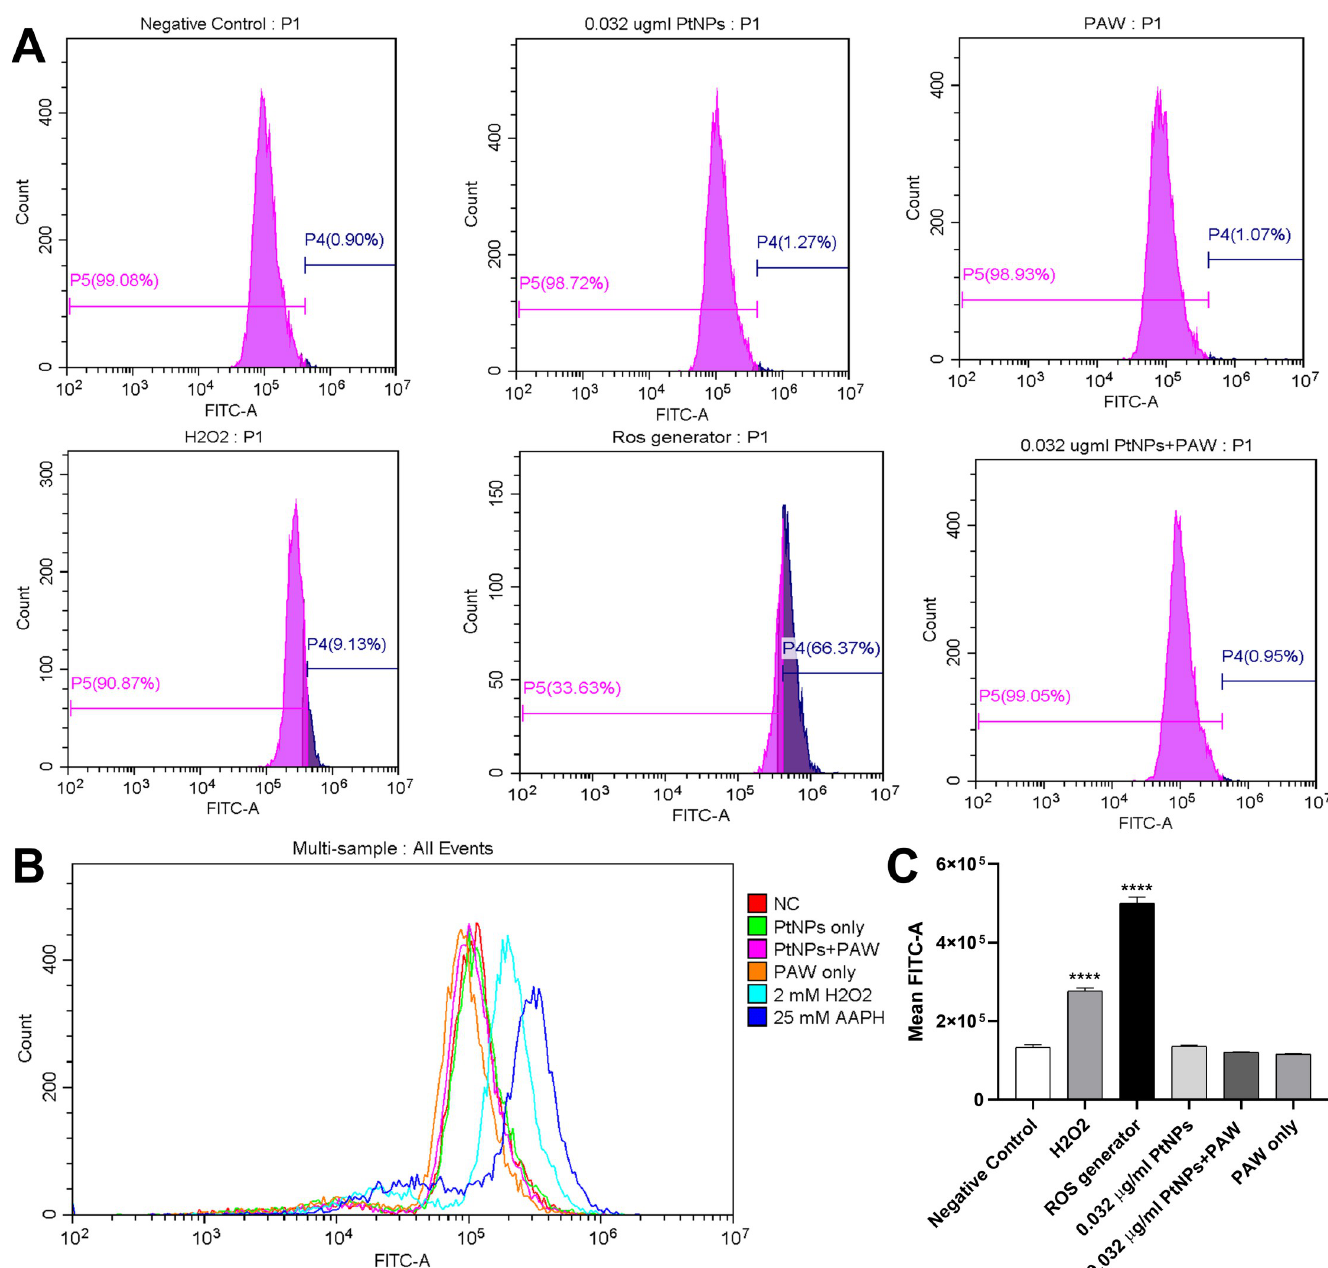
Fig 8. Intracellular reactive oxygen species production in U-251 MG. U-251 MG cells were incubated with 0.032 μ g/ml PtNPs for 24 h and then treated with 10% PAW. (A) Histograms representing negative control, 0.032 μ g/ml PtNPs, 0.032 μ g/ml PtNPs combined with 10% PAW, 10% PAW only, H 2 0 2 and ROS generator as positive controls. (B) Multi-comparison of ROS production in U-251 MG cells. (C) Mean fluorescence level of oxidised H2DCFDA in cells.